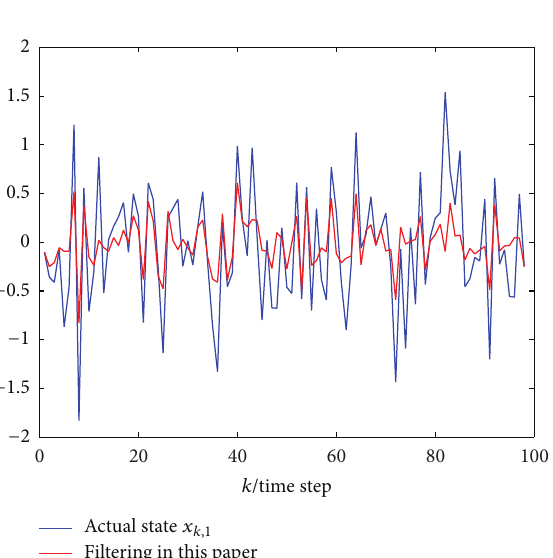
Figure 7: log(MSE1) (Case